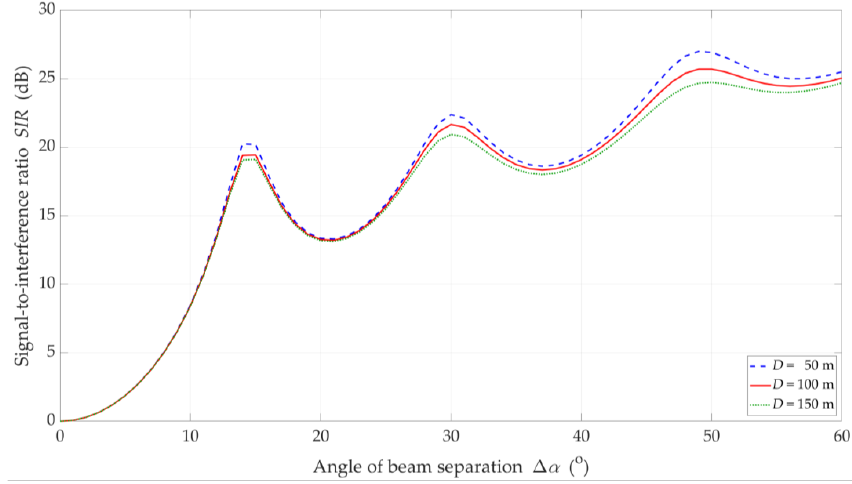
Figure 6. SIR versus separation angle for DL scenario, selected D = {50, 100, 150} m, and LOS (TDL-D) conditions.